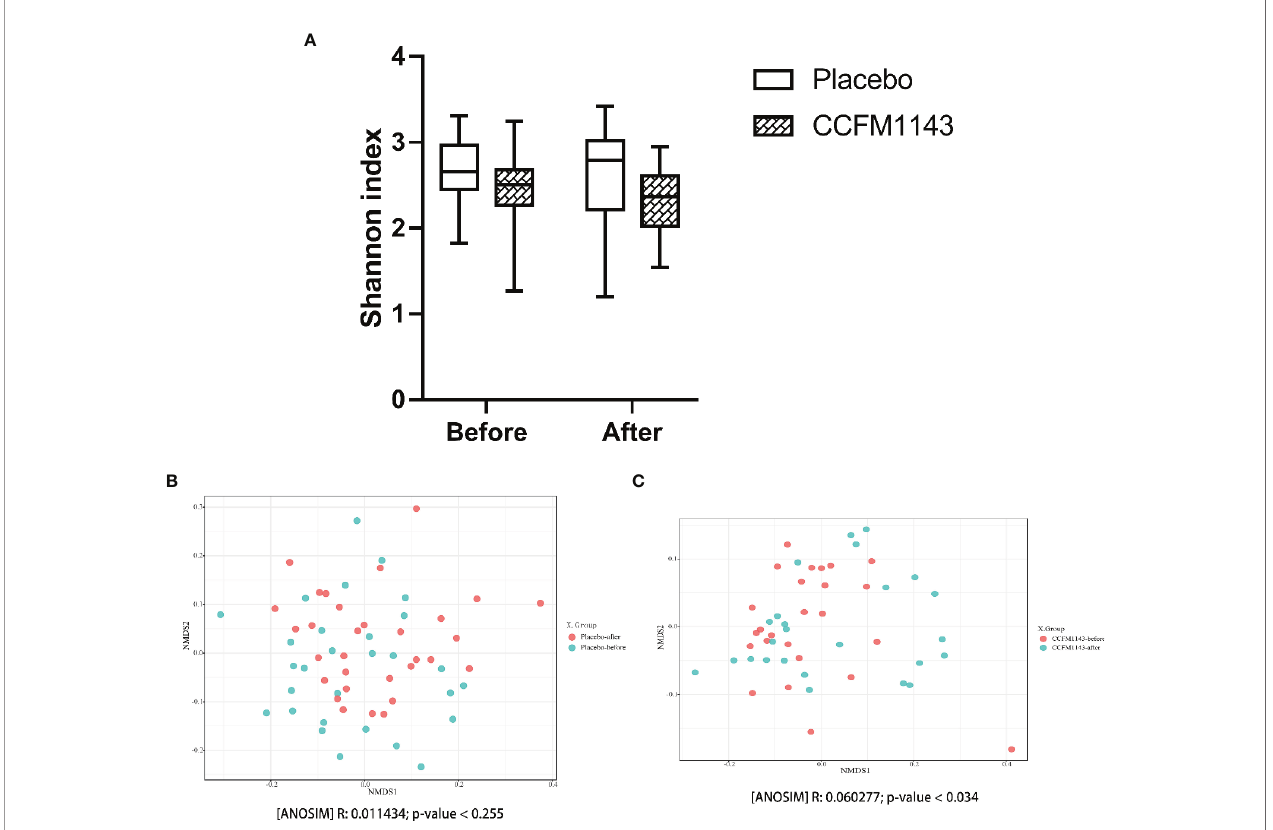
FIGURE 4 | Effect of Lactobacillus plantarum CCFM1143 on the diversity of the gut microbiota in patients with diarrhea. (A) Alpha diversity indicated by the Shannon index. (B) Beta diversity of the placebo group indicated by non-metric multidimensional scaling (NMDS). (C) Beta diversity of the L. plantarum CCFM1143 group indicated by